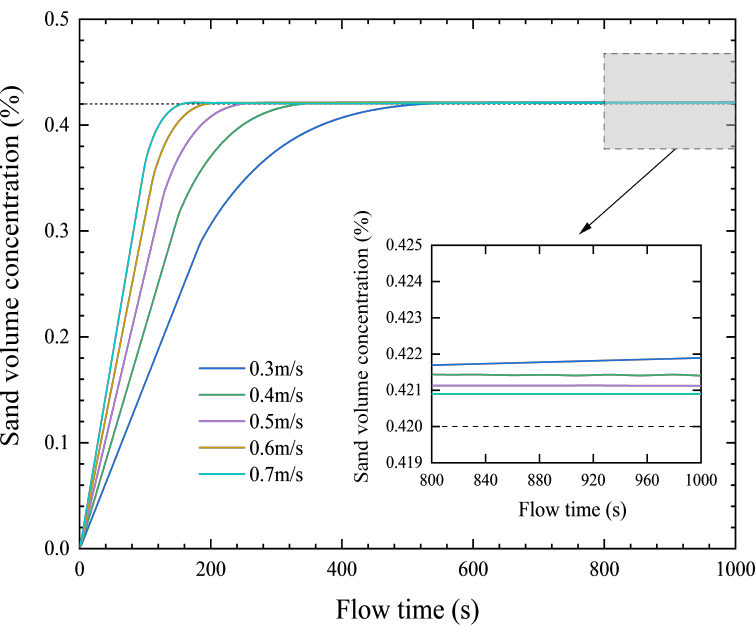
Figure 4. Sand volume concentration changes with flow time (horizontal pipe L = 80 m d = 0.02